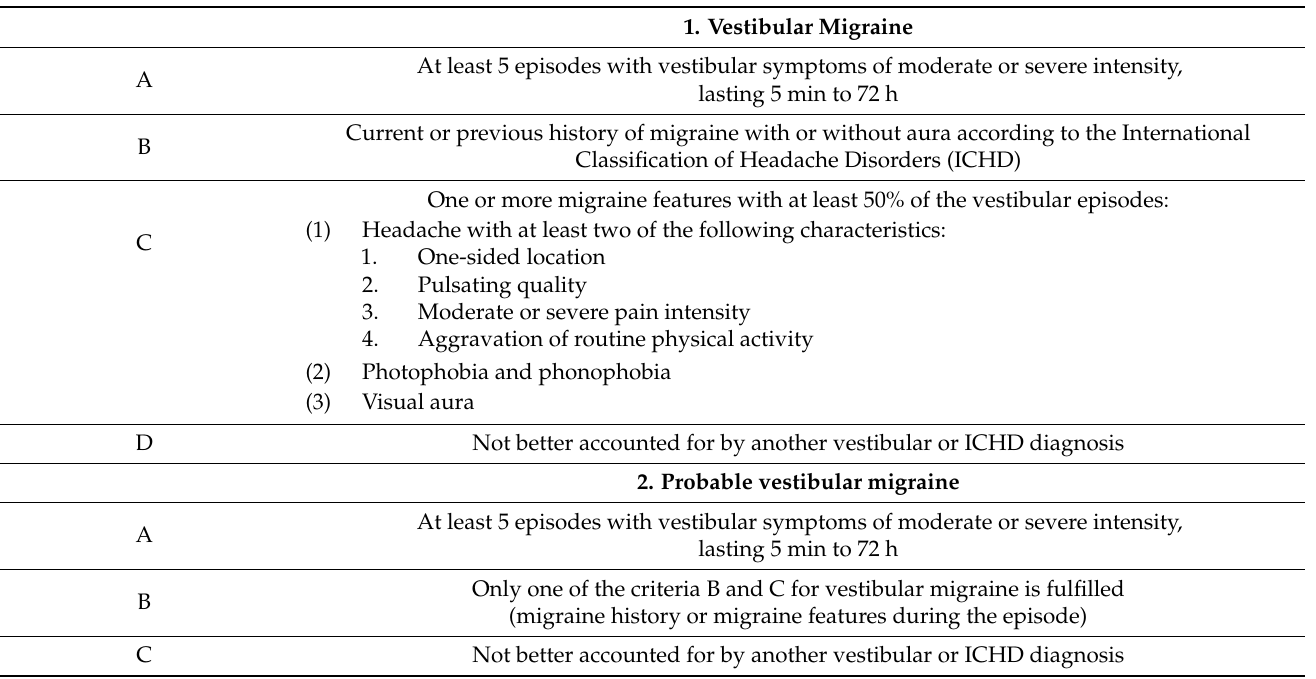
Table 1. Diagnostic criteria for vestibular migraine proposed by B á r á ny Society and the third International Classification of Headache Disorders (ICHD-3) [16].